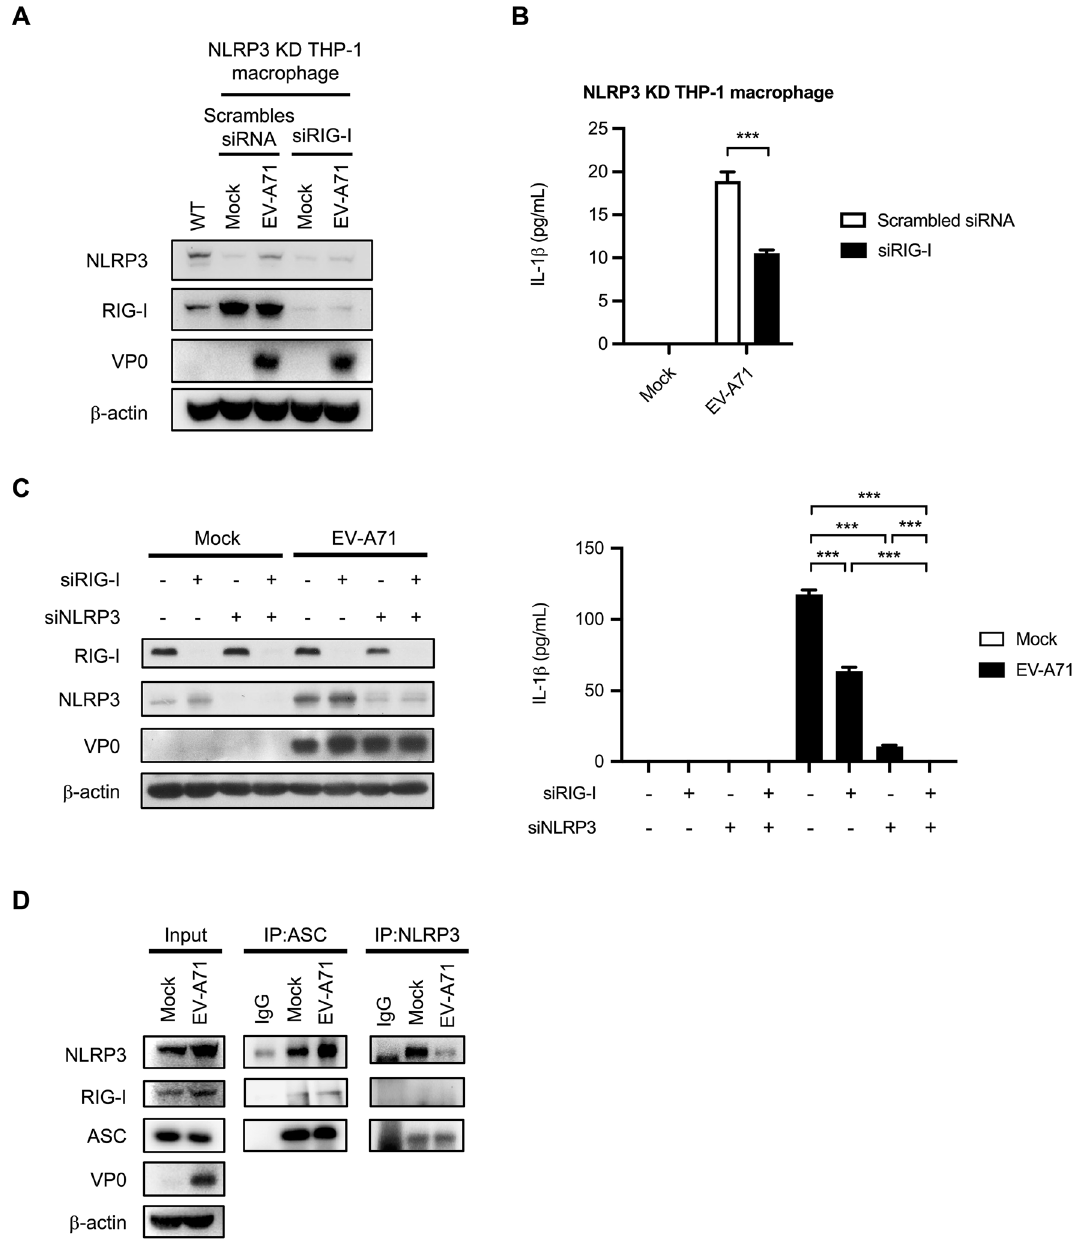
Figure 3. RIG-I contributes to IL-1β production in EV-A71-infected macrophages in an NLRP3-independent manner. ( A ) The NLRP3 KD THP-1 cells were primed with PMA for 48 h for differentiation. The primed cells were subsequently transfected with siRIG-I and scrambled siRNA for 48 h and then infected with EV-A71 (M.O.I. = 2). The expression levels of NLRP3, RIG-I, EV-A71 VP0, and β-actin were examined by Western blot. ( B ) The supernatants were harvested at 12 h p.i.. The IL-1β levels were determined by ELISA. ( C ) THP-1 macrophages were transfected with siNLRP3, siRIG-I, and siNLRP3 + siRIG-I for 48 h, respectively. The transfected cells were subsequently infected with EV-A71 at the M.O.I. of 2. The expression levels of RIG- I, NLRP3, EV-A71 VP0, and β-actin were examined by Western blot. IL-1β levels in the supernatants were determined by ELISA. ( D ) Lysates prepared from mock- or EV-A71-infected PMA-primed THP-1 cells were subjected to immunoprecipitation with anti-ASC or anti-NLRP3 antibodies attached to sepharose. Whole lysates and immunoprecipitates were analyzed by immunoblotting with anti-NLRP3, anti-RIG-I, and anti-ASC. The expression of β-actin was used as an internal control. Data are expressed as mean value ± SD (*** p < 0.001, Student’s unpaired